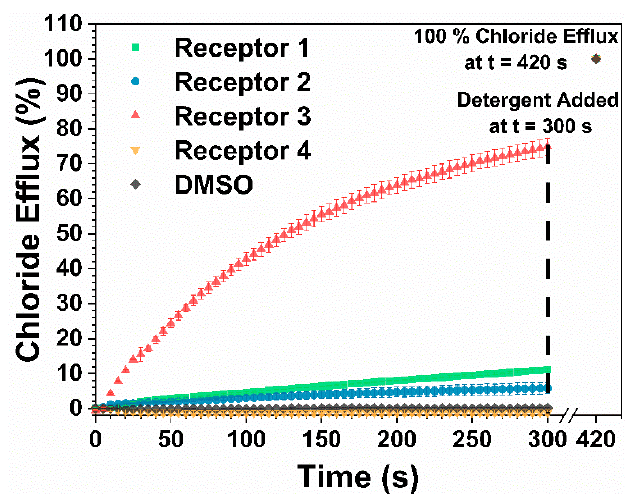
Figure 4. A comparison of the chloride efflux between receptors 1 – 4 when 1 mol%, with respect to the lipid concentration, was added to the medium. Table 2. The initial transport rates of electrogenic and electroneutral transport of receptors 1 – 4 .